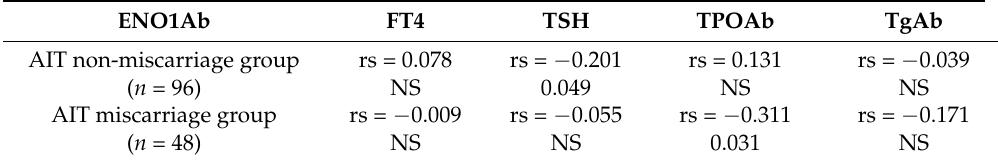
Table 3. Spearman correlation analysis of ENO1Ab expression with serum levels of FT4, TSH, TPOAb, and TgAb in AIT